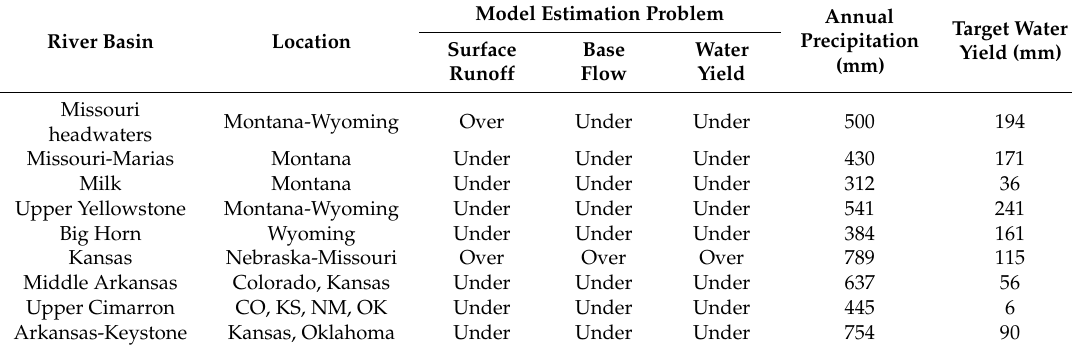
Table 3. Major mismatches between the Soil and Water Assessment Tool (SWAT) predictions and calibration